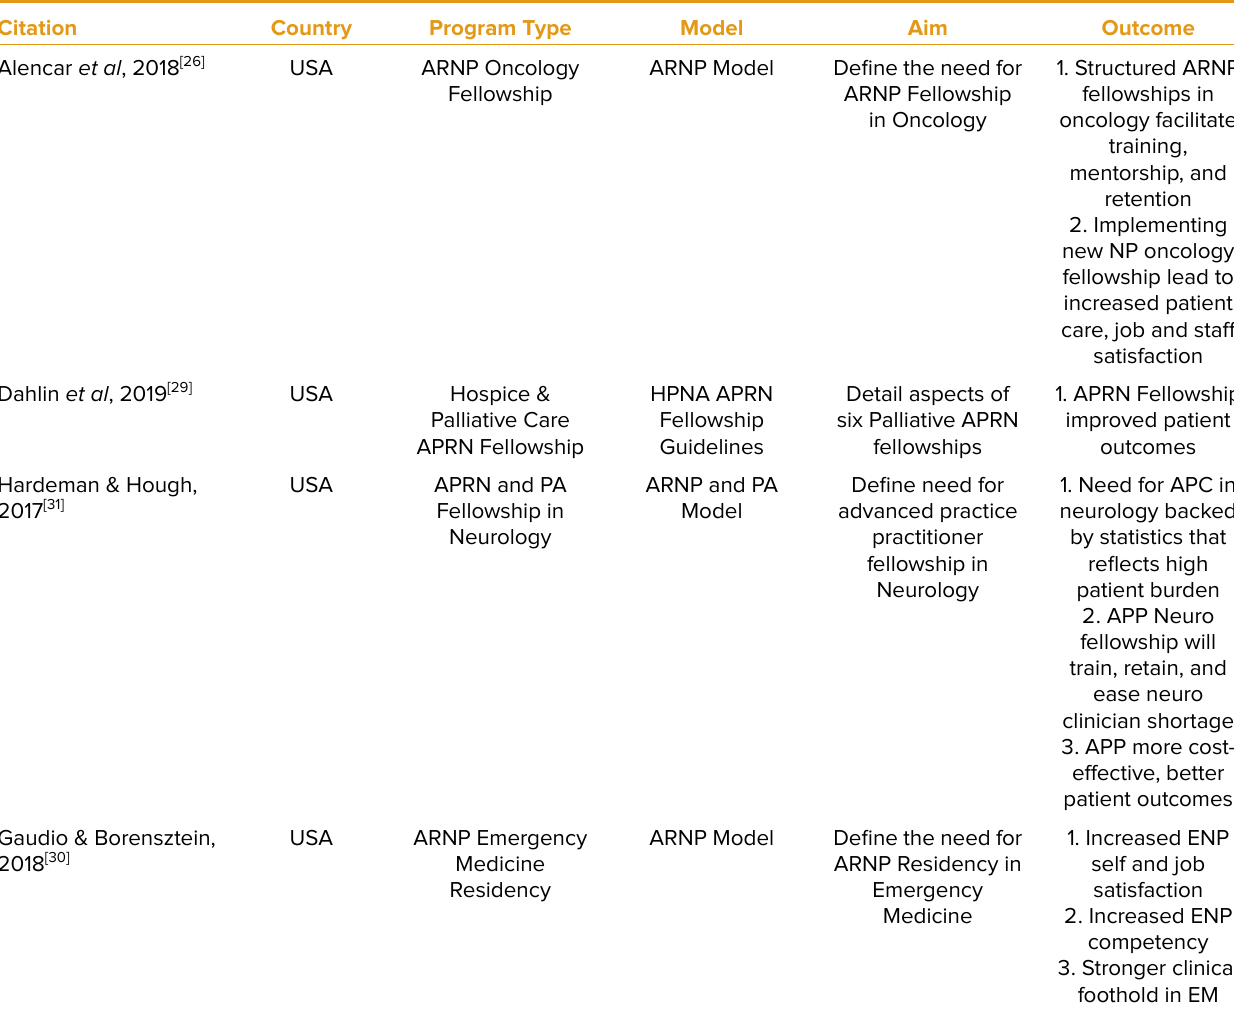
Table 1. Examples of US NP fellowships across medical specialties in the past 5 years